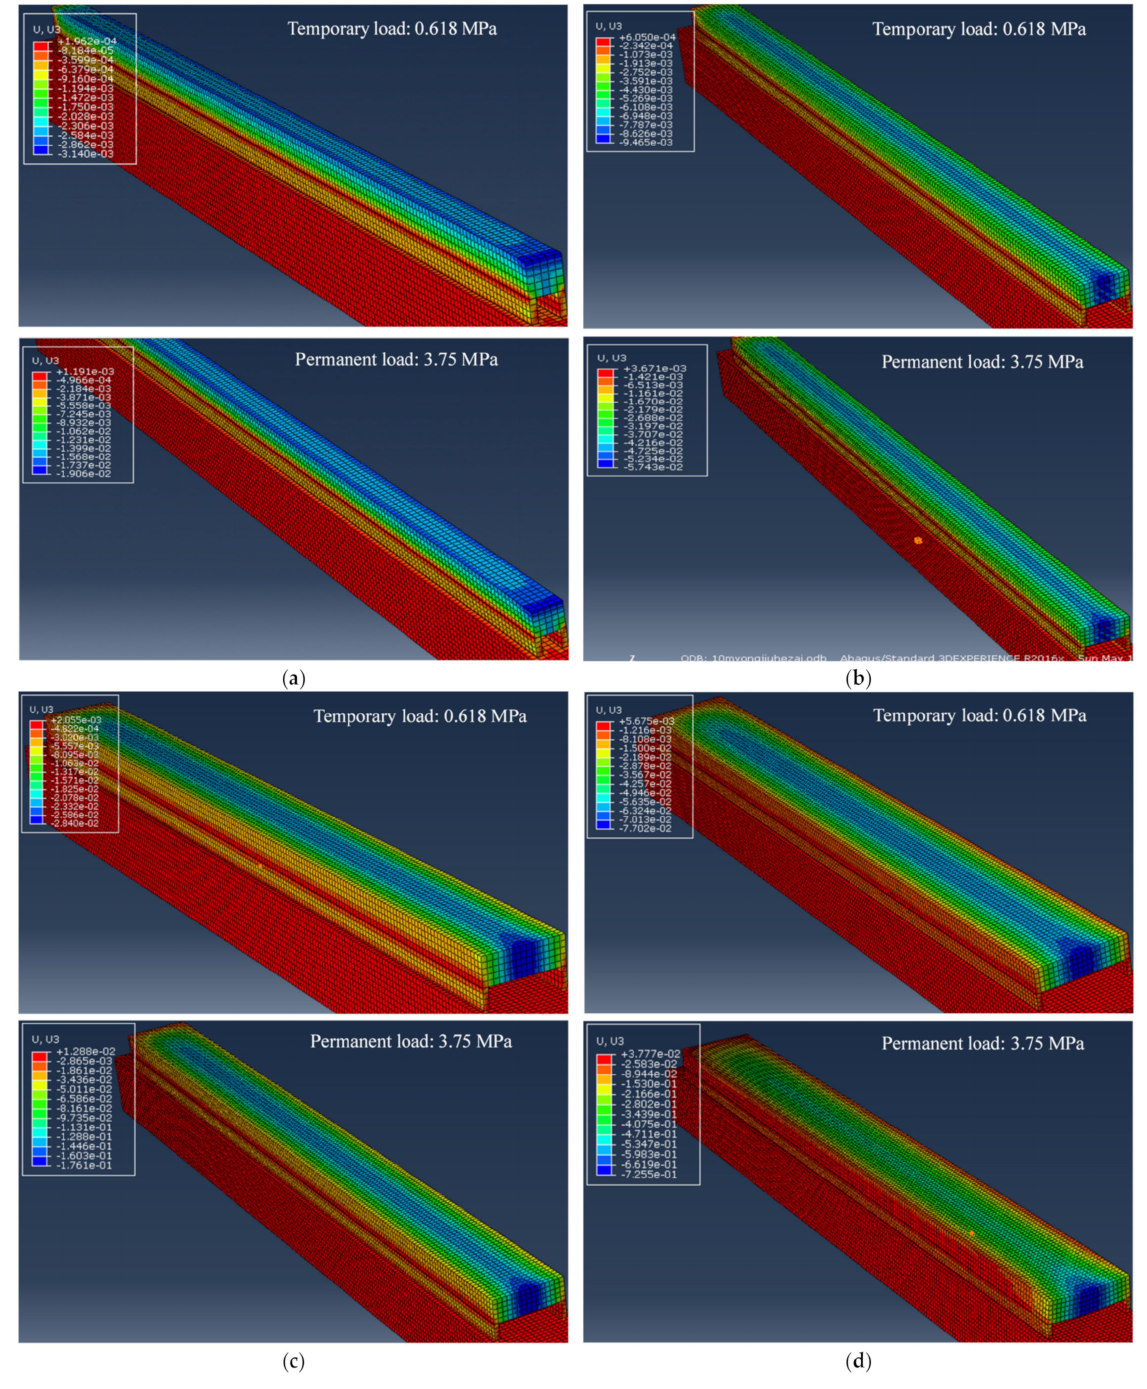
Figure 10. Vertical displacement cloud distribution map under different support barricade spacing. ( a ) Support barricade spacing is 5 m; ( b ) Support barricade spacing is 5 m; ( c ) Support barricade spacing is 15 m; and ( d ) Support barricade spacing is 20